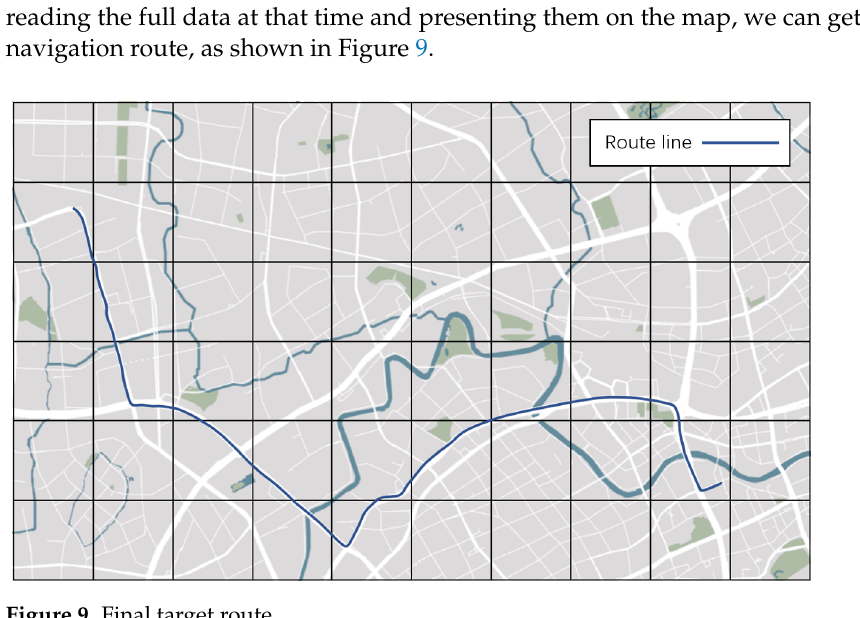
Figure 9. Final target route.